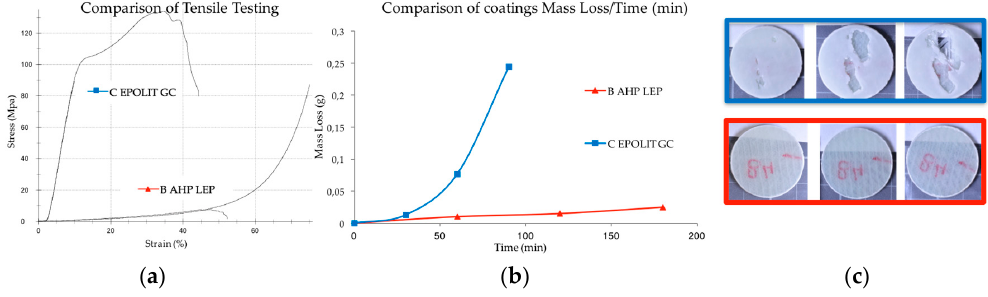
Figure 14. ( a ) Tensile test of a rigid in-mould coating (EPOLIT GC) compared with an elastomeric LEP coating (AEROX AHP LEP); ( b ) Average mass loss versus time for the two different coating technologies; ( c ) Images of erosion damage after 30, 60 and 90 min. (EPOLIT GC, upper series in blue and AEROX AHP LEP, lower series in red).